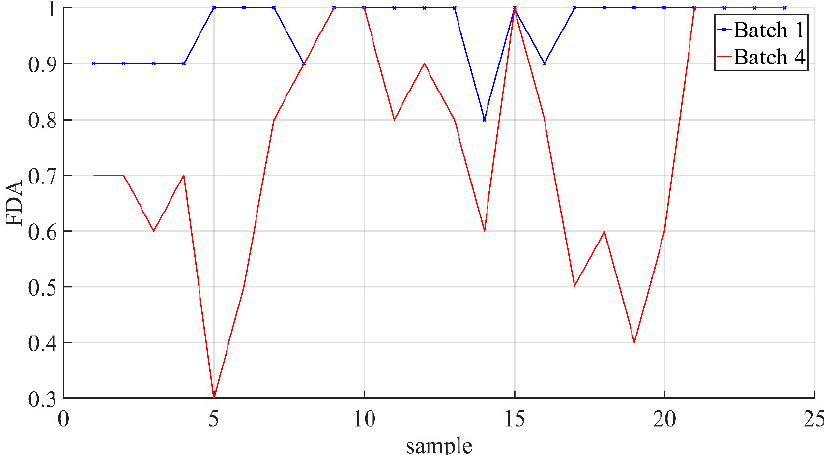
Figure 6. The relationship of the average diagnostic rate in 10 time windows under different normal conditions.